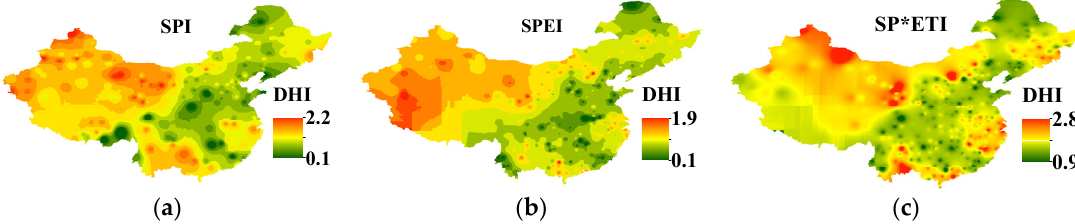
Figure 2. Historical distribution of DHI. ( a ) DHI calculated by SPI, ( b ) DHI calculated by SPEI, ( c ) DHI calculated by